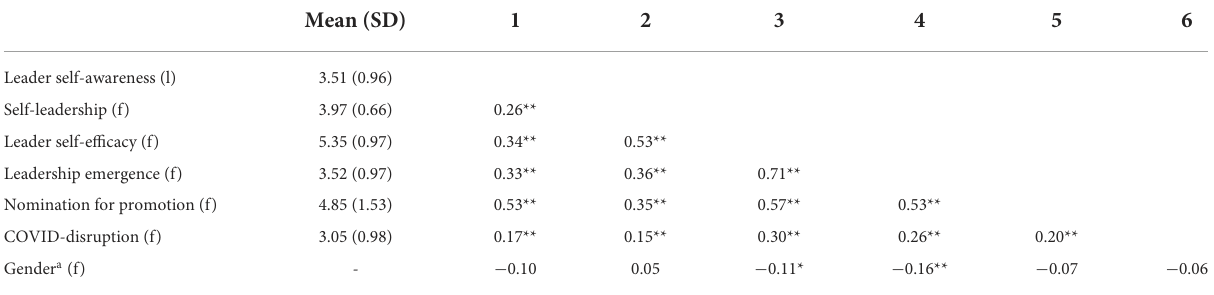
TABLE 2 Means, standard deviations, and bivariate correlations for Study 2.